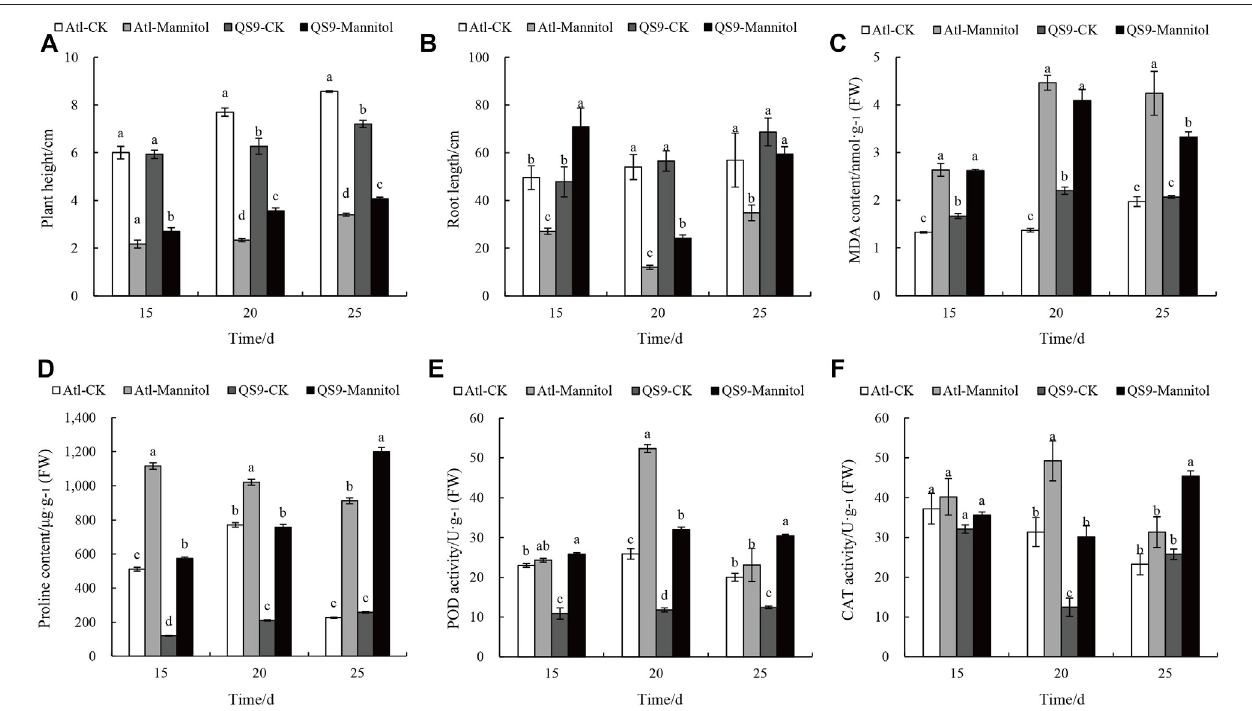
FIGURE 8 | Changes in phenotypic and physiological indexes of potato test-tube plantlets in different periods under drought treatment. (A,B) height of plants and root length in control and mannitol-induced drought treated media measured in cm. (C) MDA content (nmol/g FW) of QS9 and Atl under stressed and unstressed conditions. (D) Proline content ( μ g/g FW) under drought conditions. (E,F) POD and CAT activities (U/g FW) in mannitol-induced drought treatment and control. Different letters show signi fi cant differences between treatments. Duncan ’ s method was used for signi fi cance analysis for multiple comparisons ( p <